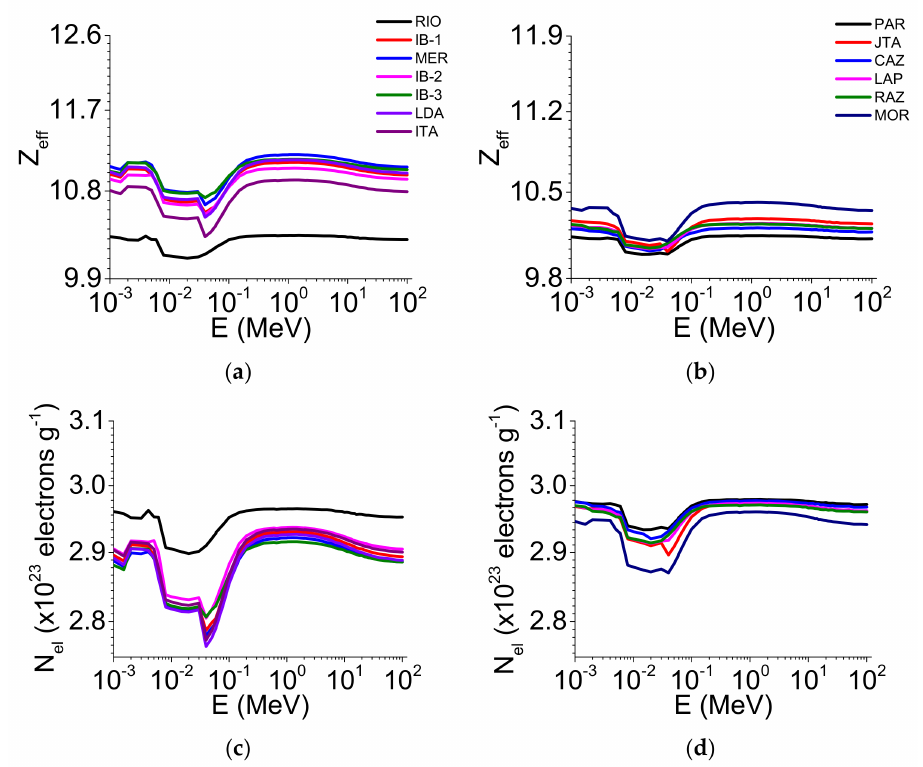
Figure 5. Effective atomic number (Z eff ) and electron density (N el ) variation as a function of the photon energy (E) (1 keV–100 MeV) for the <45 µ m aggregate sizes in the clayey soils ( a , c ) and the loamy/sandy soils ( b , d